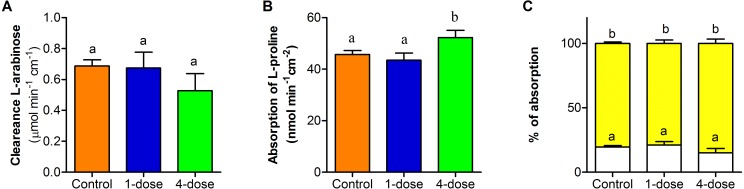
Effect of PVF from the eggs of Pomacea maculata on mice intestinal permeability.(A) Changes in permeability determined by the clearance of L-arabinose during a 2-h intestinal perfusion. (B) Absorption of L-proline calculated per nominal intestinal area during 2-h intestinal perfusion. (C) Relative absorption by the paracellular (white bars) and transcellular (yellow bars) pathways of L-proline, based on the absorption of L-arabinose. Control group n = 9; one-dose n = 9; four-dose n = 8. Data are the mean ± s.e.m; bars that share letters indicate no statistically significant difference (P > 0.05).